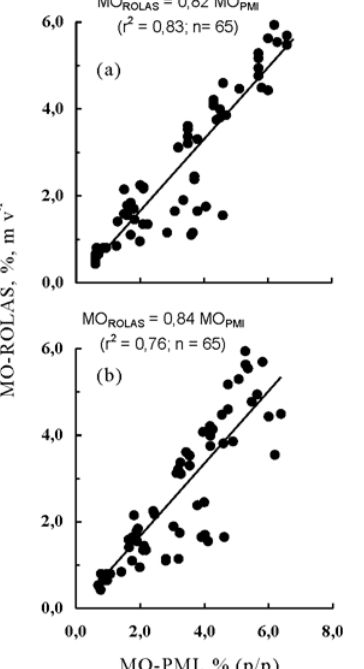
Figura 3. Relação entre os teores de matéria orgânica (MO) determinados com os métodos solução sulfocrômica (ROLAS) e perda de massa por ignição (PMI), em amostras de solos do Rio Grande do Sul. Valores obtidos com o método PMI e expressos (a) em base de massa (m m -1 ) e (b) em base de volume (m v -1